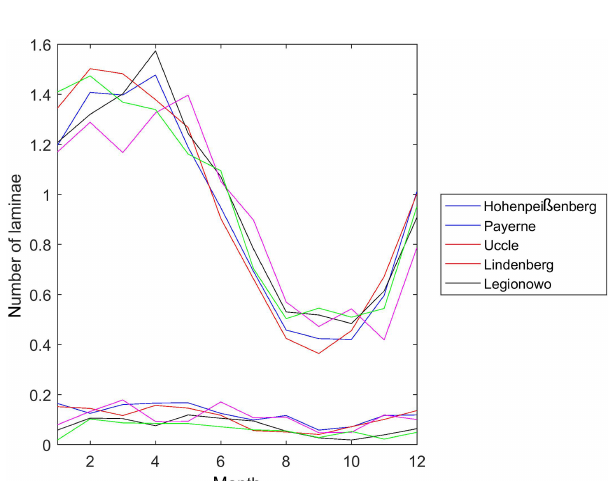
Figure 5. Long-term evolution of the average vertical resolution of profiles at the European ozonosonde stations.